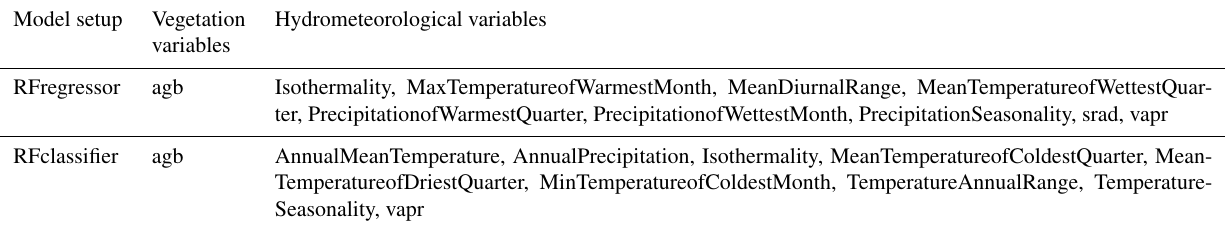
Table 1. List of the predictors confirmed as important by the feature selection algorithm for RFregressor and the RFclassifier models. See Table S1 for details on the variable